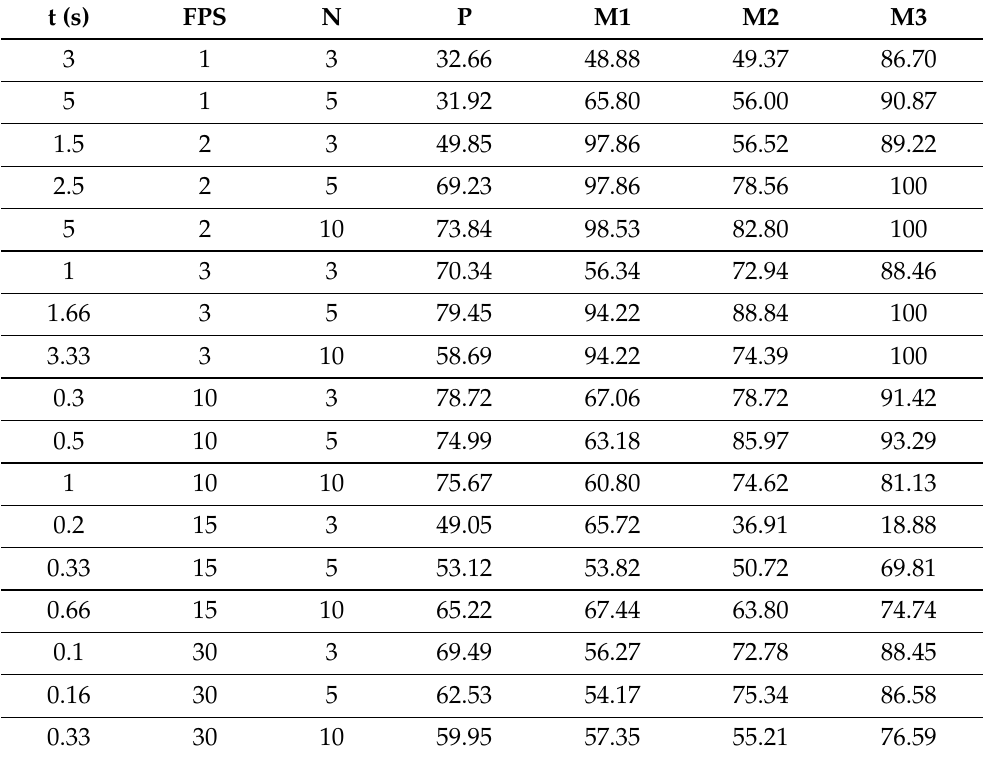
Table 8. Results from video sampled at varying FPS rates. N is the number of images used. P is the overall probability of correct classification based on N images. M1, M2, and M3 refer to the ‘Discard’, ‘Consensus’, and ‘Discard + Consensus’ methods described in Section 4.2 for image